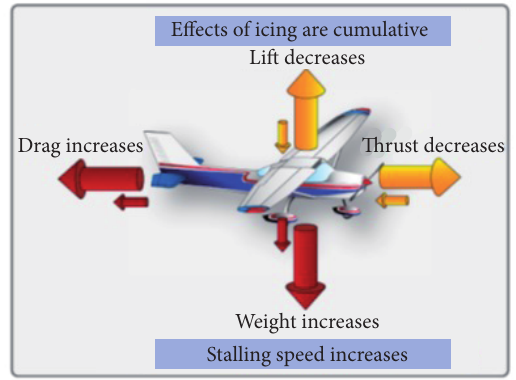
Figure 11. Ice accumulation on aircraft surfaces (Cao et al. 2015; Stothers 2013).